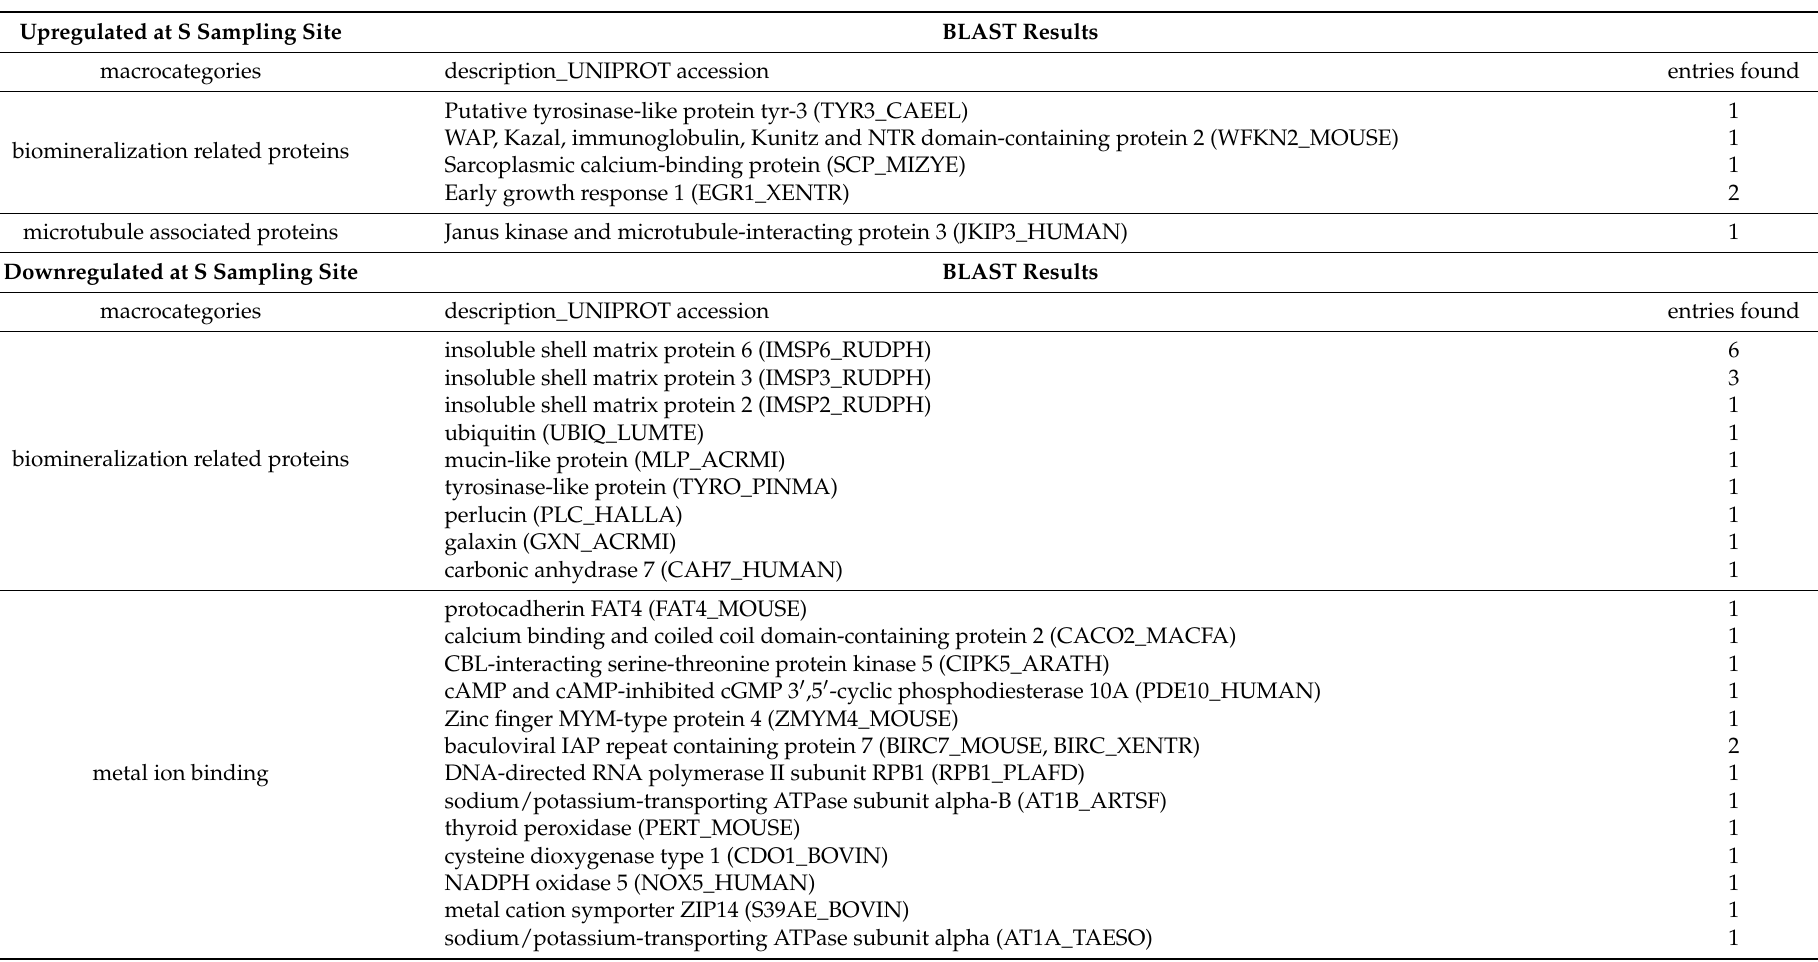
Table 1. Differentially expressed genes (DEGs) obtained for Senigallia (S) and Silvi Marina (SM) sampling sites and their related annotation description and entries